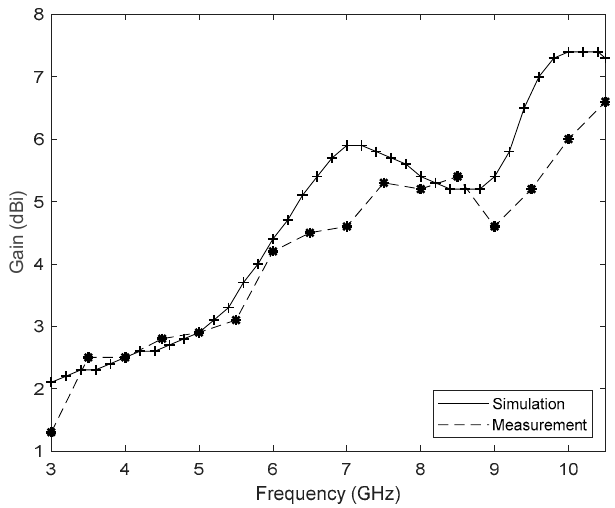
Figure 12. Measured and simulated gain for the proposed antenna.